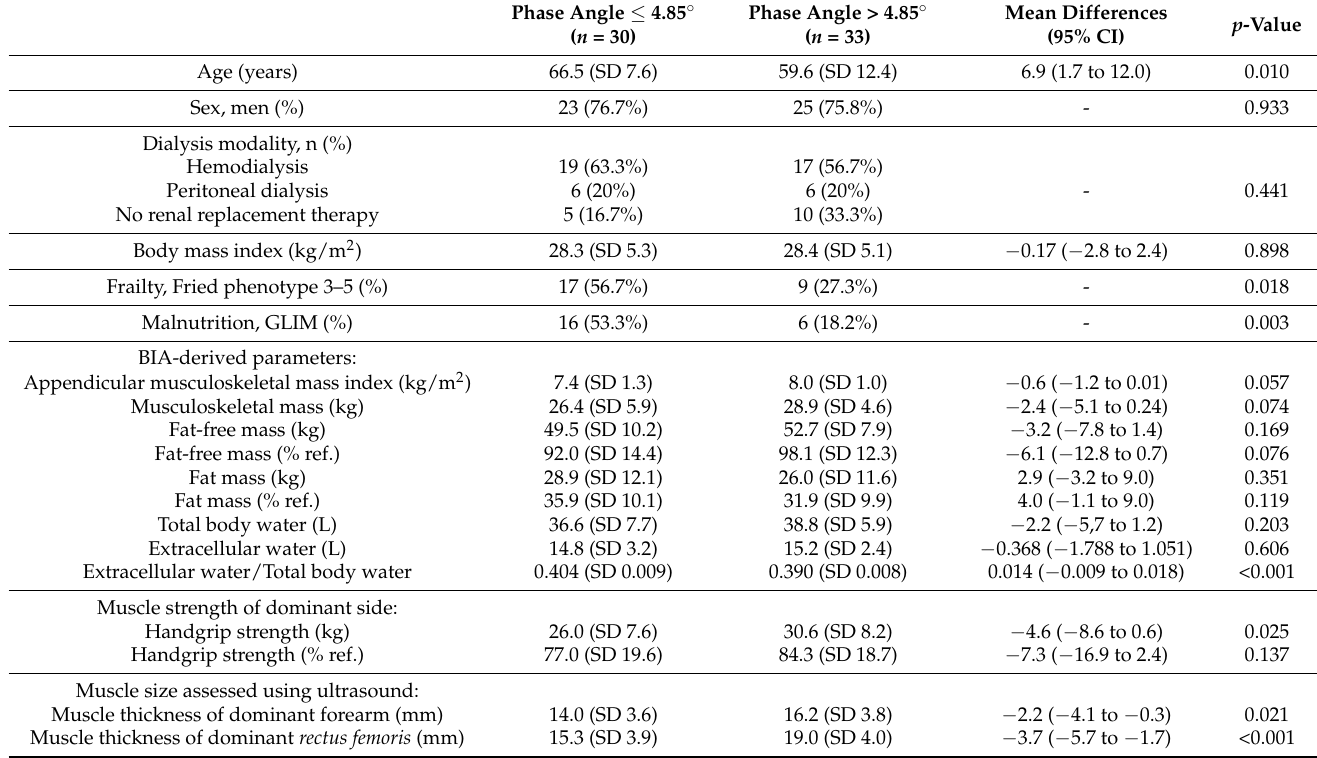
Table 4. Univariate analysis comparing patients according to values of the phase angle ( ≤ 4.85 ◦ ).